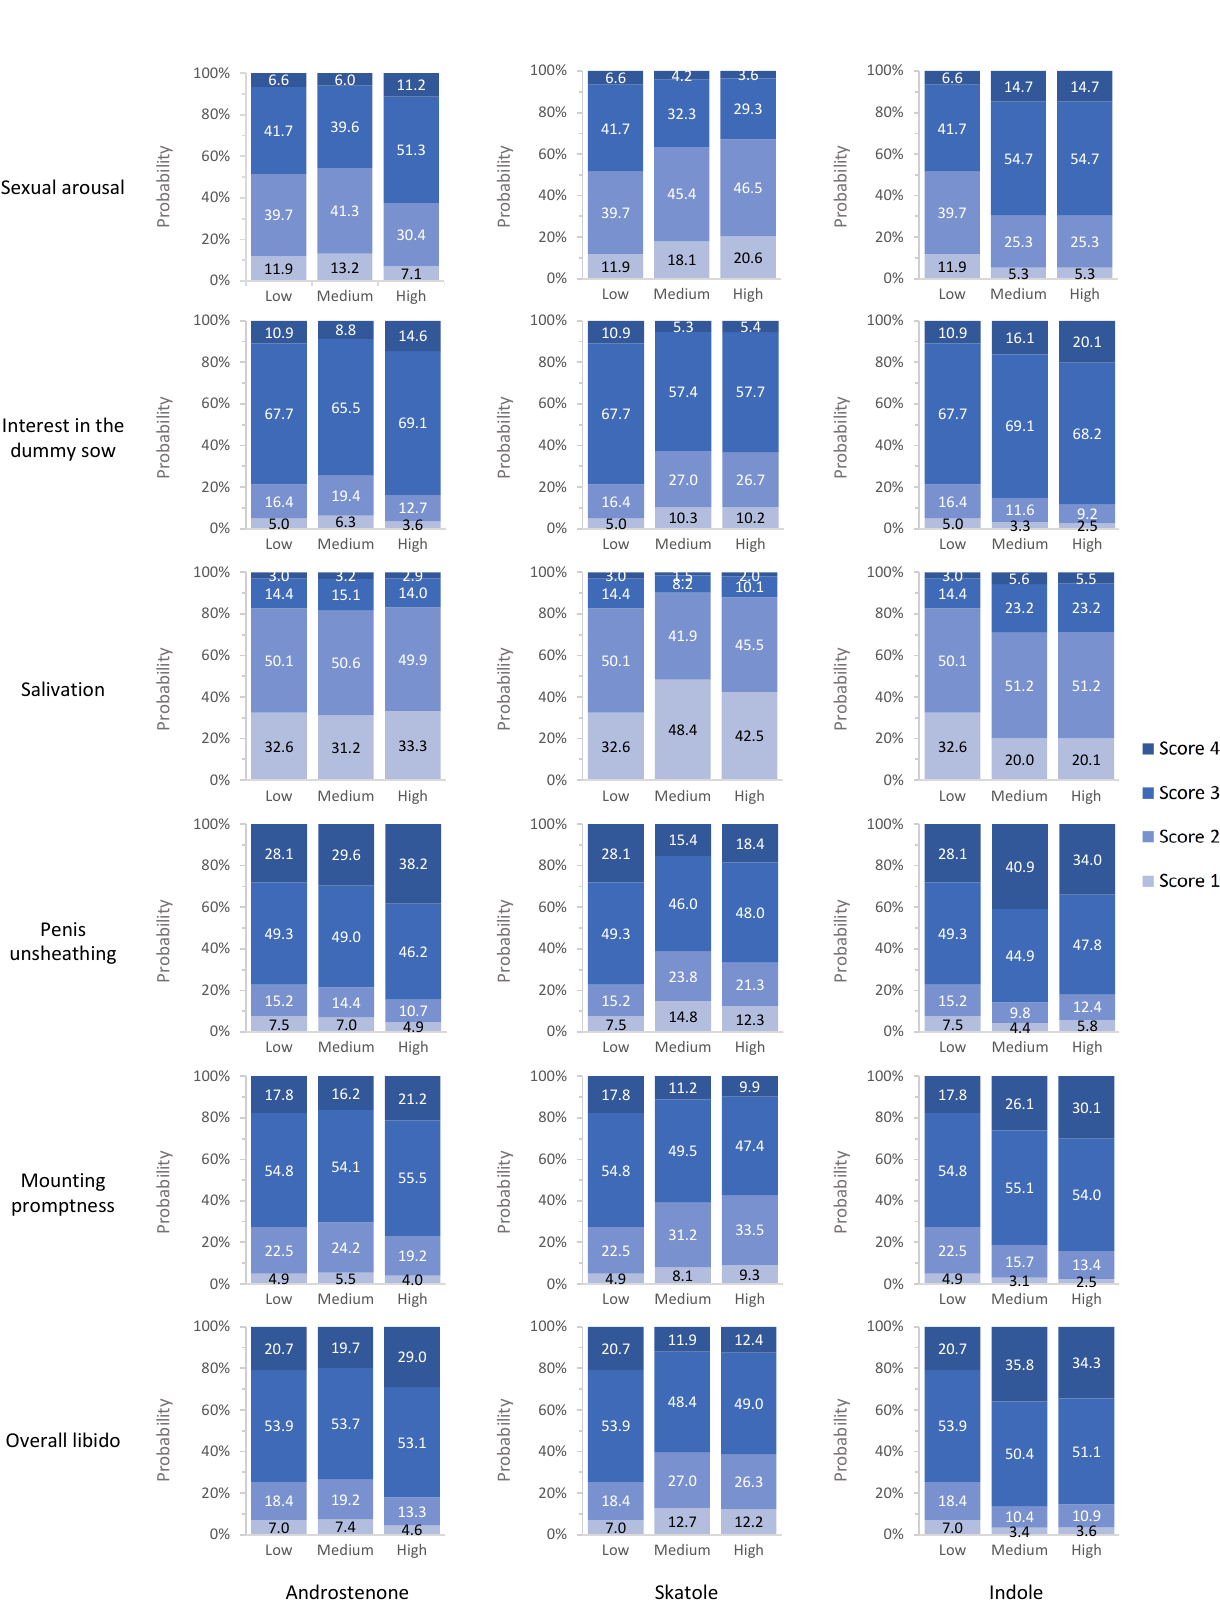
Figure 6. Probabilities of score 1 to 4 at low, intermediate, or high levels of each boar taint compound (at constant low level of the others) for the investigated sexual behavior